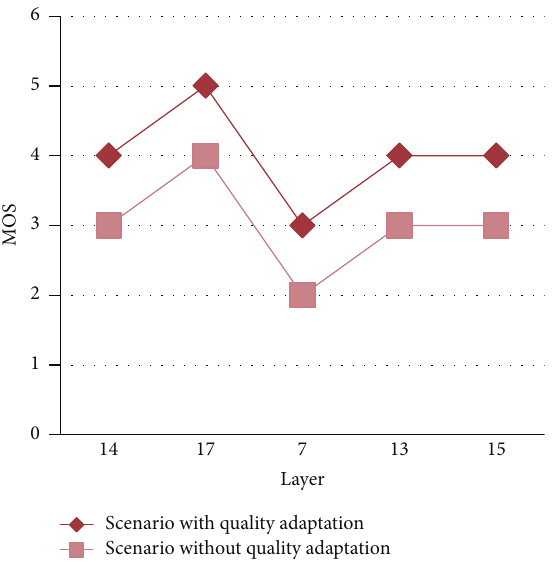
Figure 6: MOS in the scenario without quality adaptation and with quality adaptation by LLI.